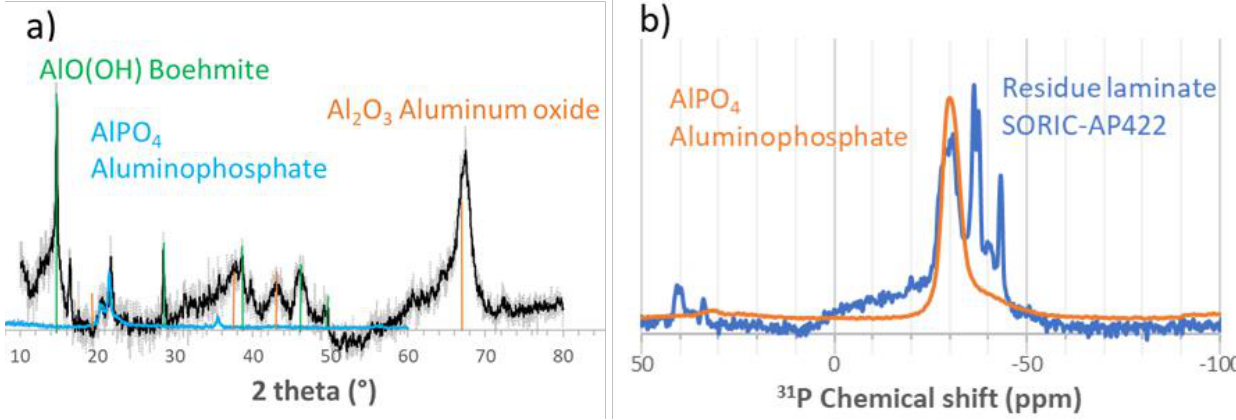
Figure 7. XRD analyses ( a ) and 31 P NMR spectrum ( b) of AP422 SORIC laminate residue.